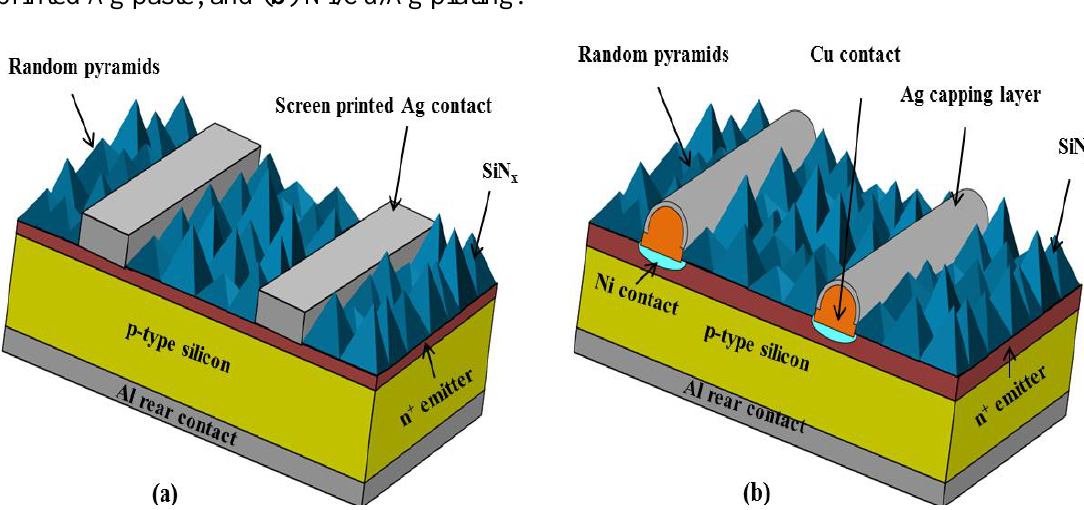
Figure 3. Solar cell structures composed of metallization scheme based on ( a ) Screen printed Ag paste; and ( b ) Ni/Cu/Ag plating.